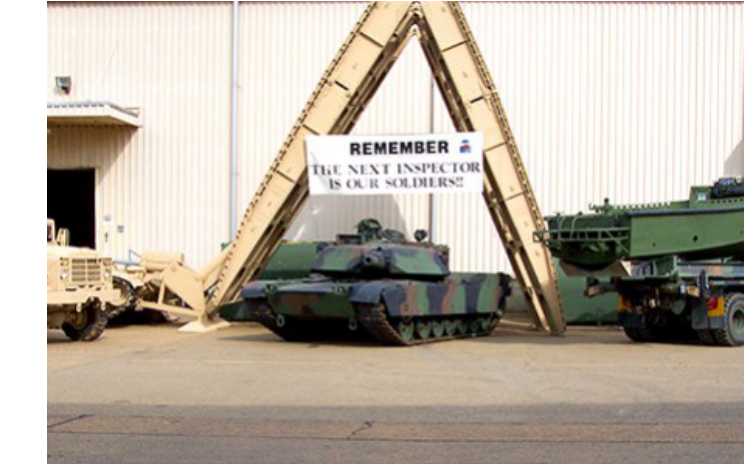
Figure 2 – A professional soldier needs a complete, functional and reliable combat vehicle Рис . 2 – Для профессионального солдата важнее всего укомплектованность , исправность и надежность боевой машины